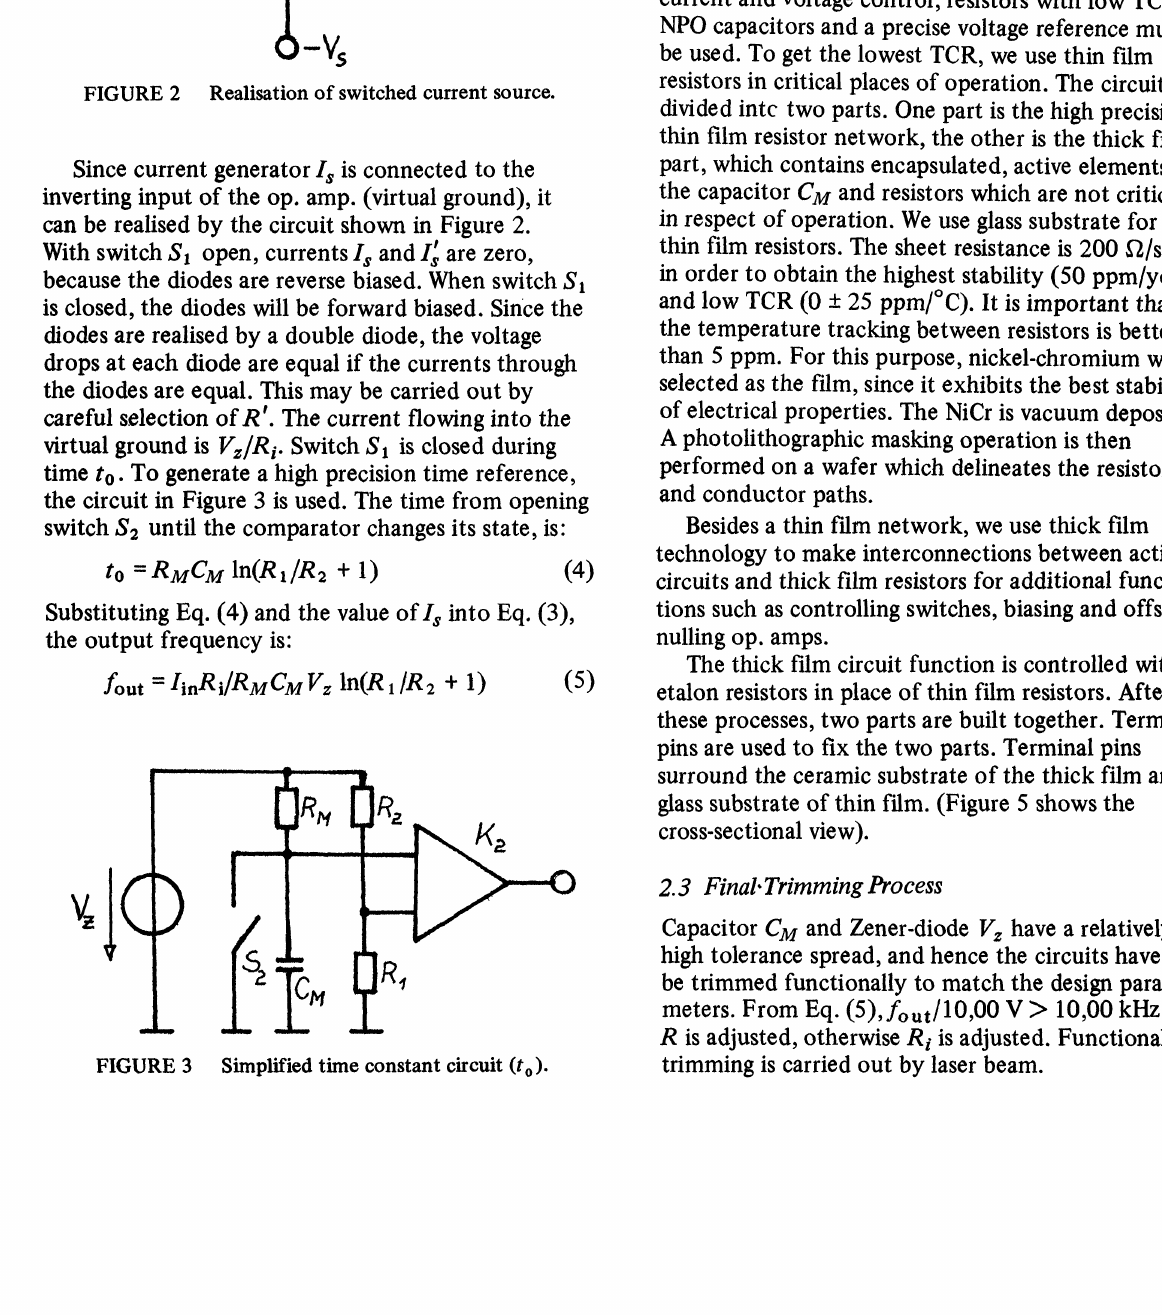
FIGURE 2 Realisation of switched current source.